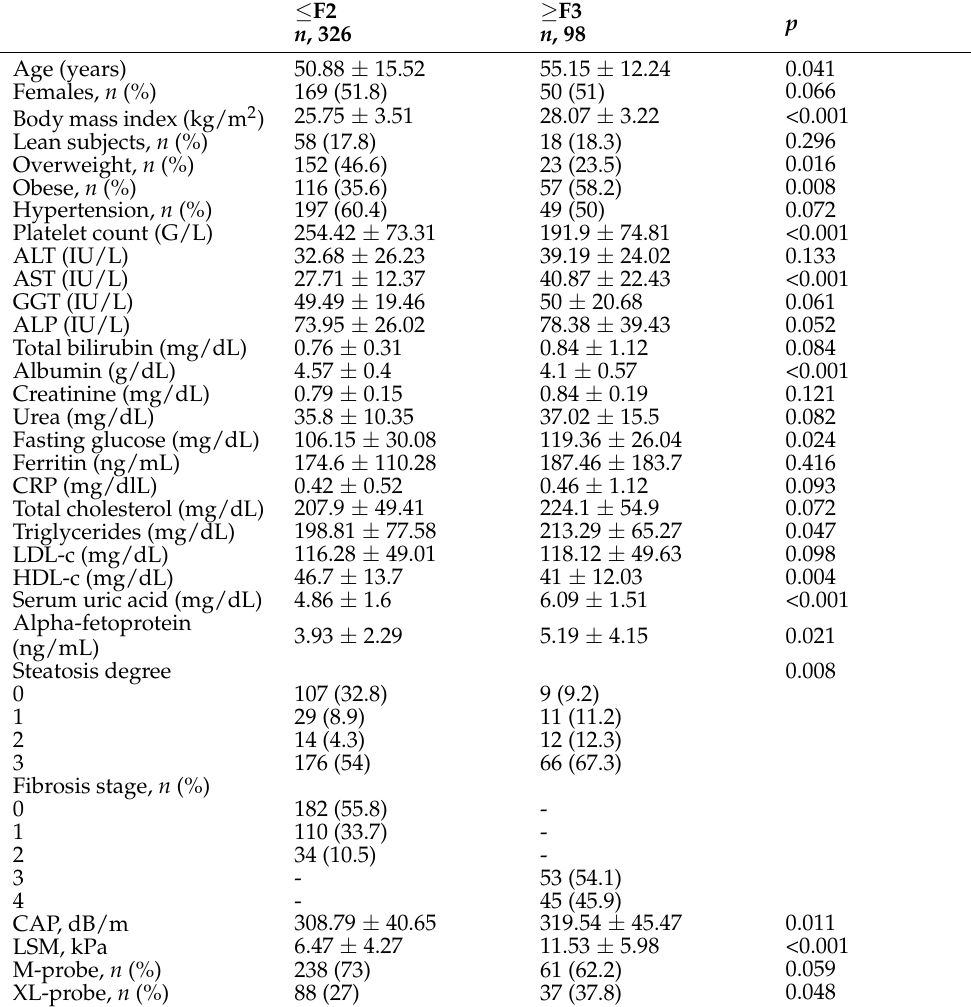
Table 2. Characteristics of patients according to liver fibrosis